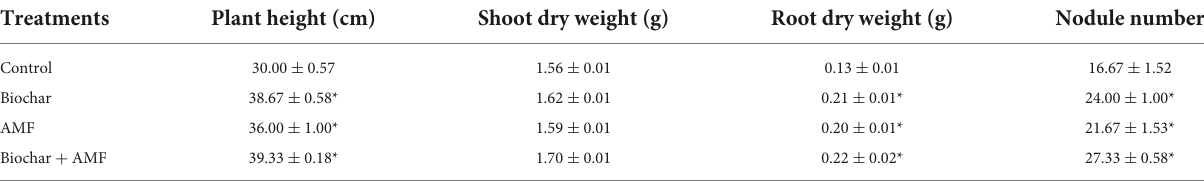
TABLE 1 The plant height, shoot dry weight, root dry weight, and nodule number in soybean as affected by biochar and AMF under drought condition. Treatments